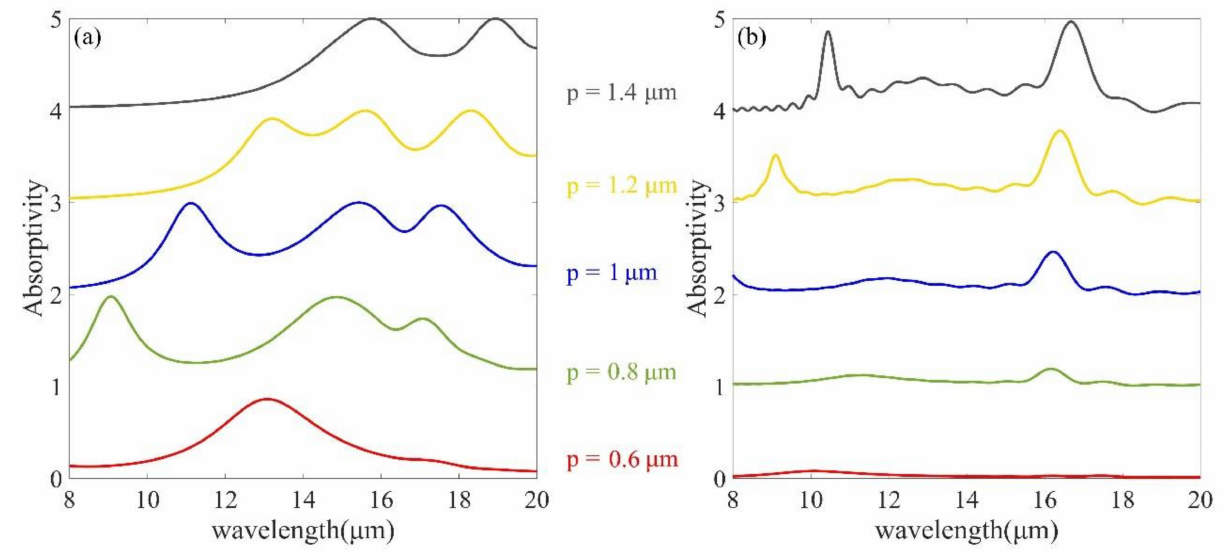
Figure 6. ( a , b ) Absorption spectra of nanodisk arrays with crystalline and amorphous phases at different periods, respec- tively. The other geometric parameters are the same as in Figure